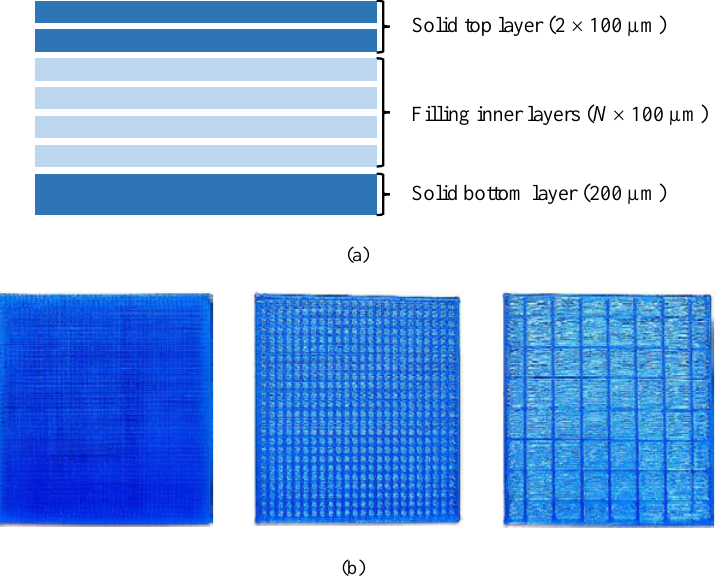
Figure 2. ( a ) Structure of the printed layers of the substrates. ( b ) Linear printing pattern of 3D material with di ff erent filling densities, 100%, 50% and 15%.